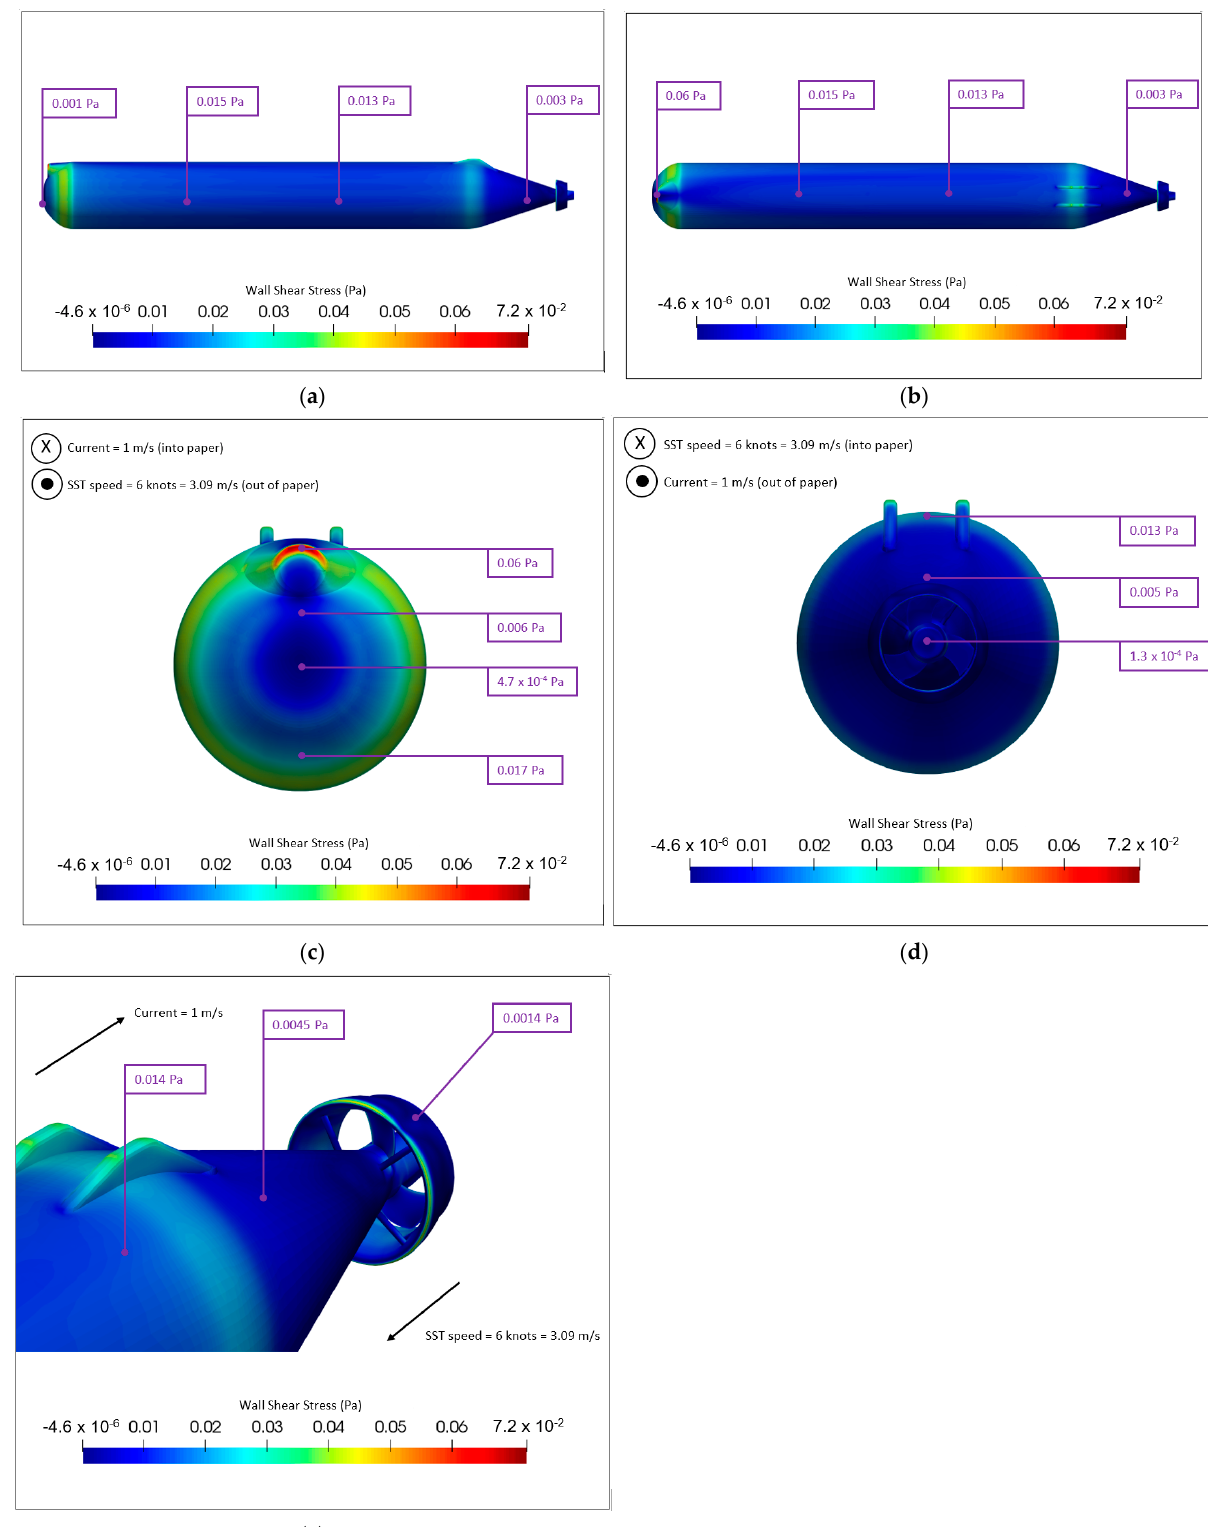
Figure 13. Skin friction distribution plots: ( a ) side view, ( b ) top view, ( c ) front view, ( d ) back view, and ( e ) zoom in at the propeller